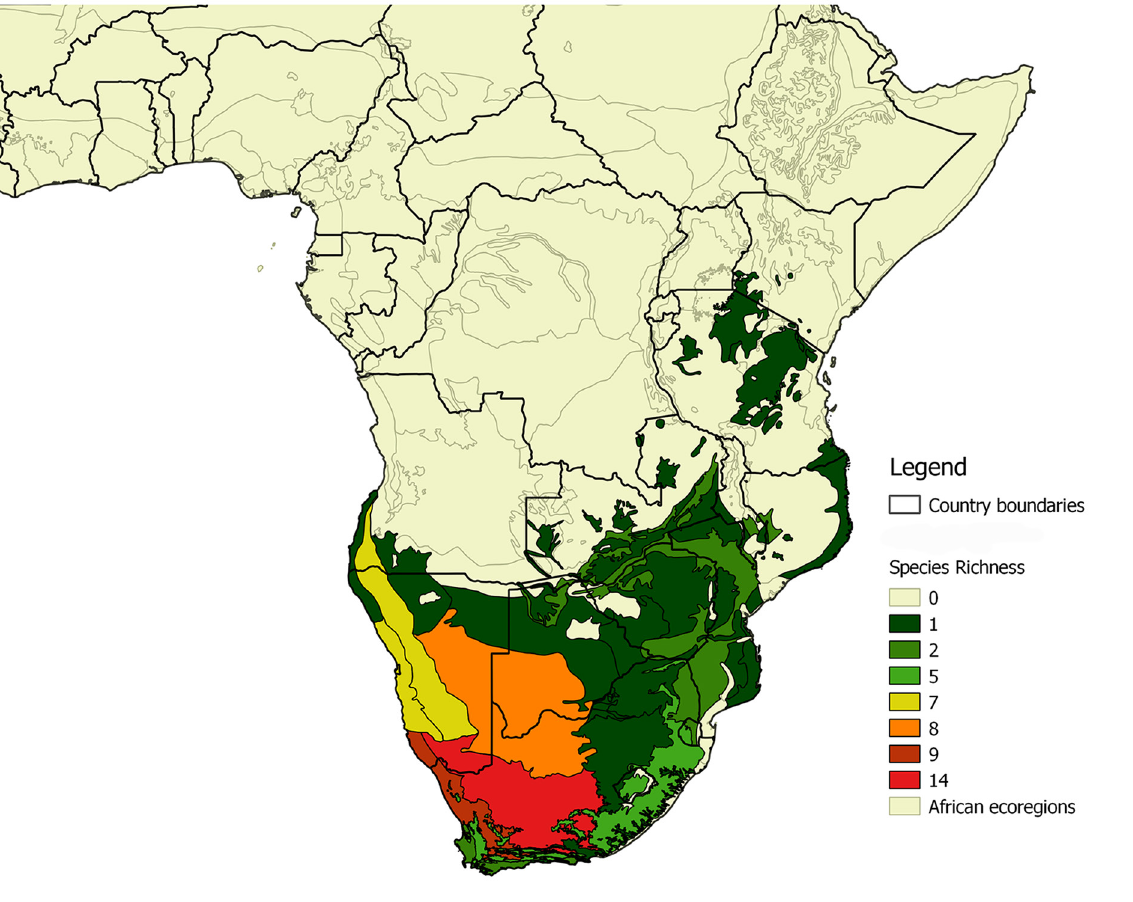
Fig. 25. Map showing the diversity of the T . solidum group across the different ecoregions of southern Africa. Numbers in the legend indicate number of